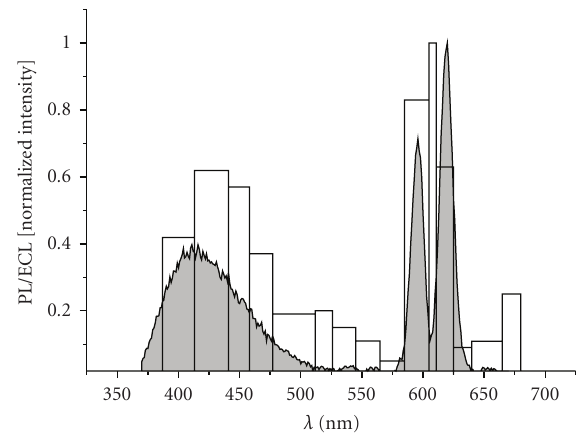
Figure 6: Photoluminescence ( λ exc = 355 nm) and electrochemi- (NO 3 )(H 2 O) complex in luminescence spectra of Eu(C3CA) 2 2 aqueous solution. Experimental conditions: Al/Al 2 O 3 as a working electrode, Pt wire as a counter electrode, applied pulse voltage − 50 V, frequency 40Hz, pulse charge 30 μ C, pH of solution 4.5, concentration of the complex 5 × 10 − 5 mol × dm − 3